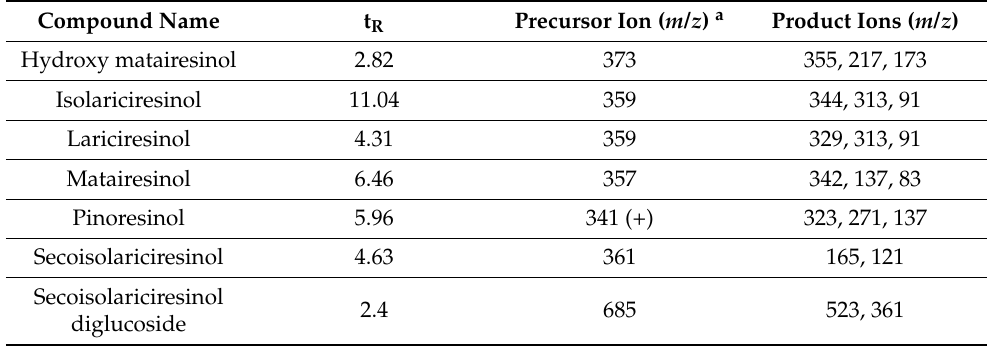
Table 1. Lignan reference standards selected for the investigation in gourmet edible oils by HPLC- MS/MS (positive and negative